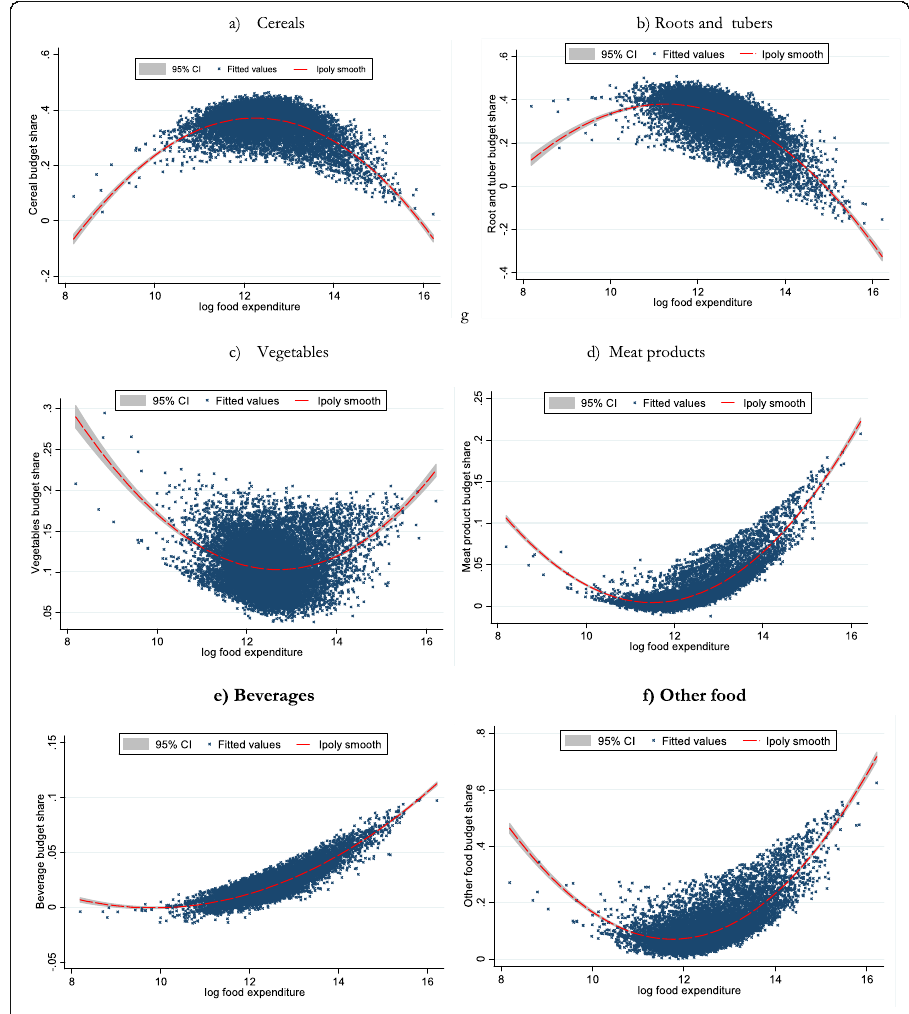
Fig. 4 Estimated Engel curves for different groups of food products in Rwanda. Notes: The estimated Engel curves have been obtained using a nonparametric approach based on the use of local quadratic polynomials. 95% CI, 95% confidence interval; “ lpoly smooth ” , smooth localized